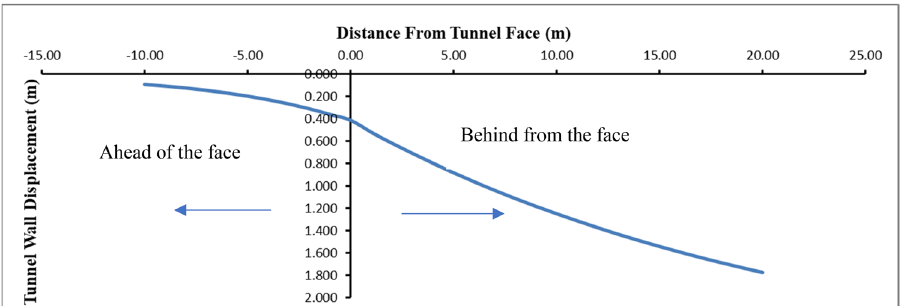
Figure 11. Longitudinal displacement profil for h = 200 m.